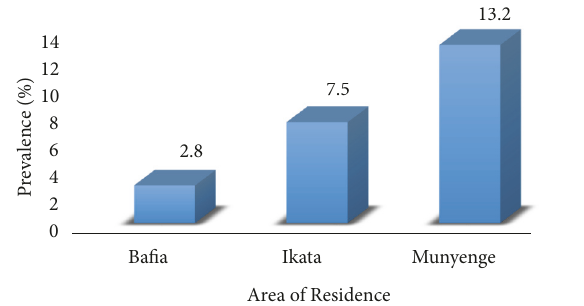
Figure 2: Prevalence of S. haematobium egg excretion in the three localities in the Bafia Health